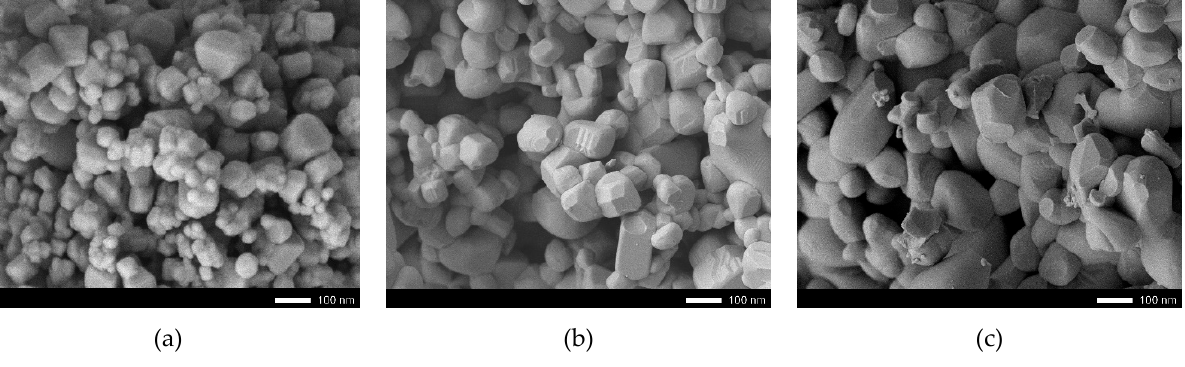
Figure 2. SEM images of synthesized ceramics: ( a ) LTO-1; ( b ) LTO-2; ( c ) LTO-3.